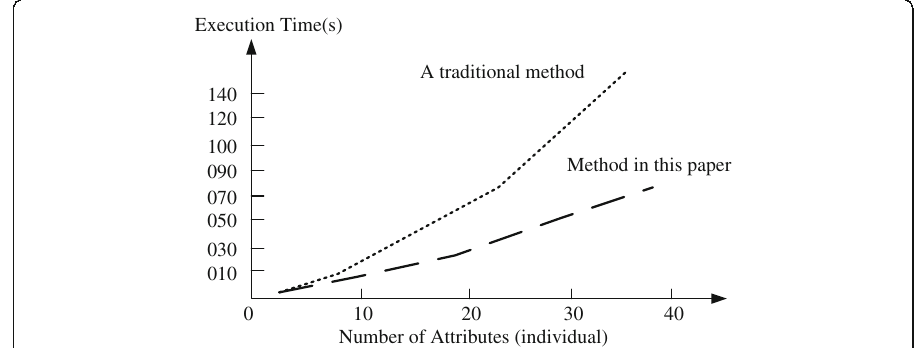
Fig. 7 Comparison of the extensibility of two